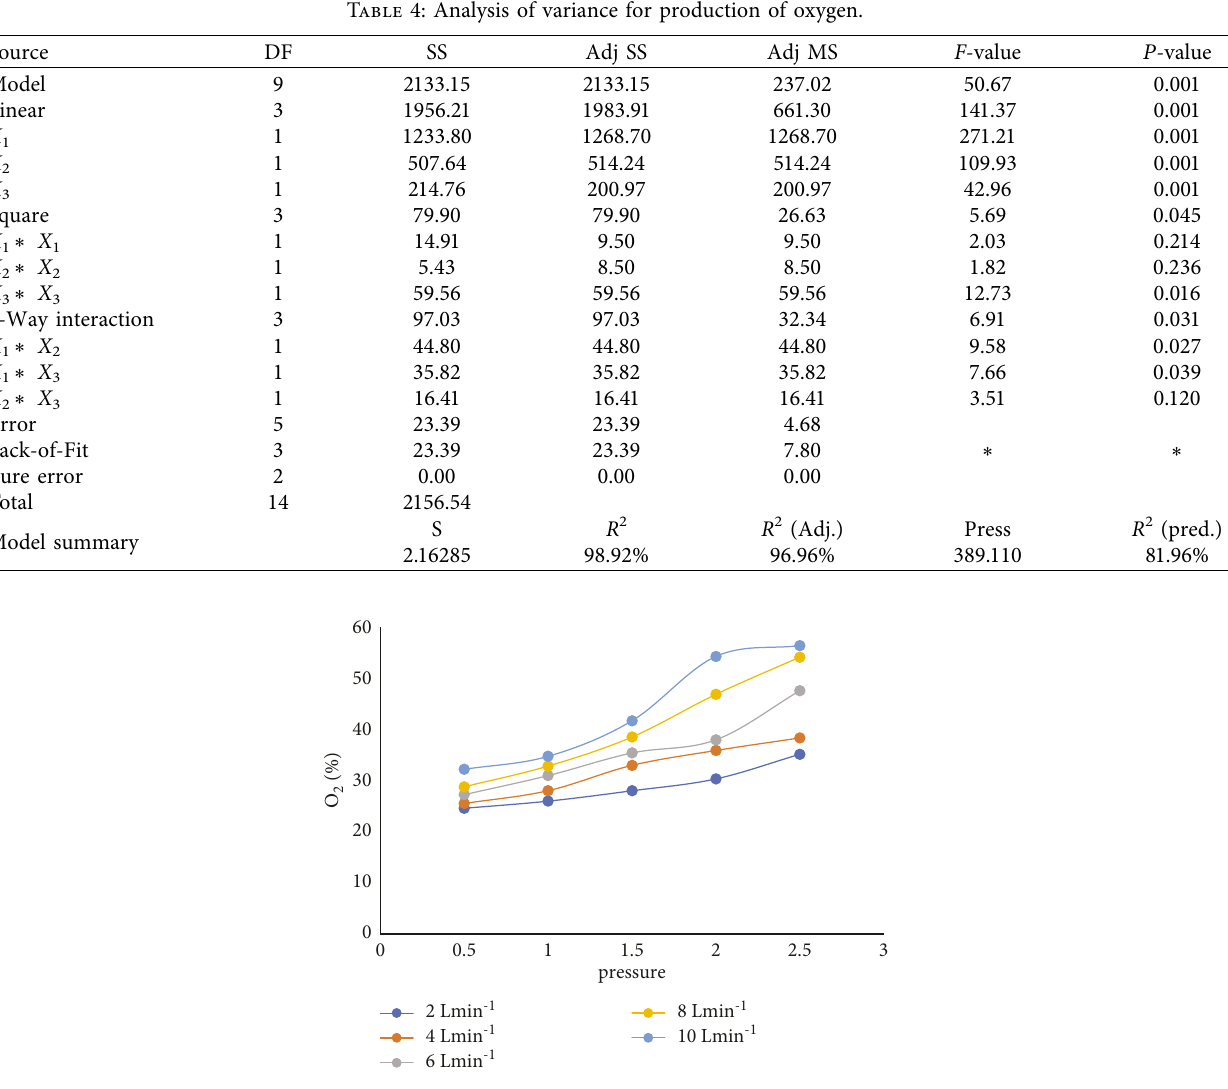
Figure 3: Oxygen purity as a function of pressure for different input air flowrates at 9 cm height of packing. Table 5: Data of oxygen purity as a function of pressure for different input air flowrates at 9cm height of packing.